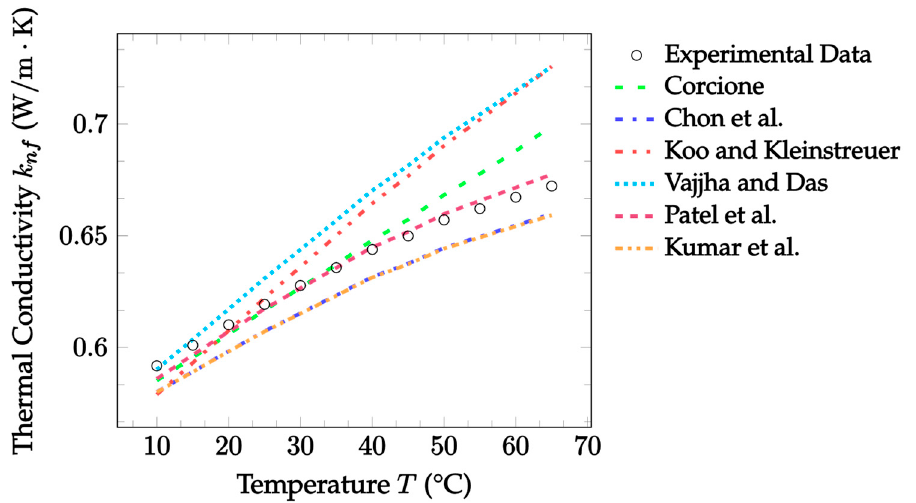
Figure 5. Brownian models as a function of temperature compared with experimental data gathered for ZrO 2 –water with 30 nm particle diameter, volume fraction of 0.2%, and temperatures ranging from 10 °C to 65 °C: Experimental Data [65], Corcione [19], Chon et al. [20], Koo and Kleinstreuer [21], Vajjha and Das [22], Patel et al. [23], Kumar et al. [24].